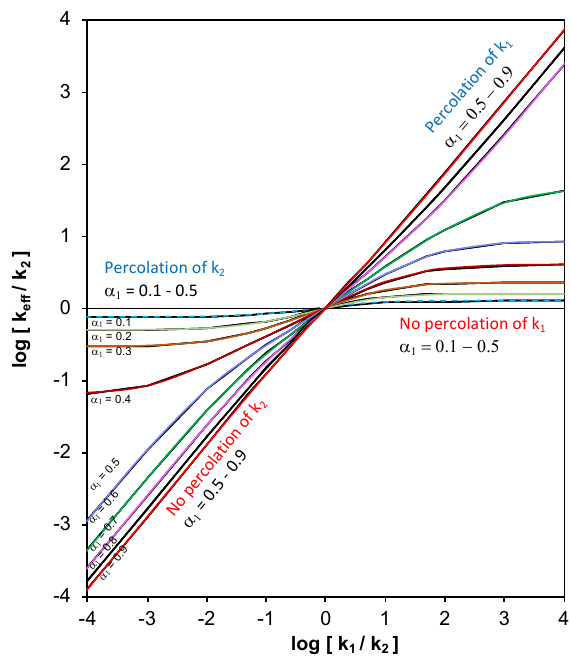
Figure 6. Summary of typical thermal network responses for range of fractions of k 1 (α 1 = 0.1–0.9).